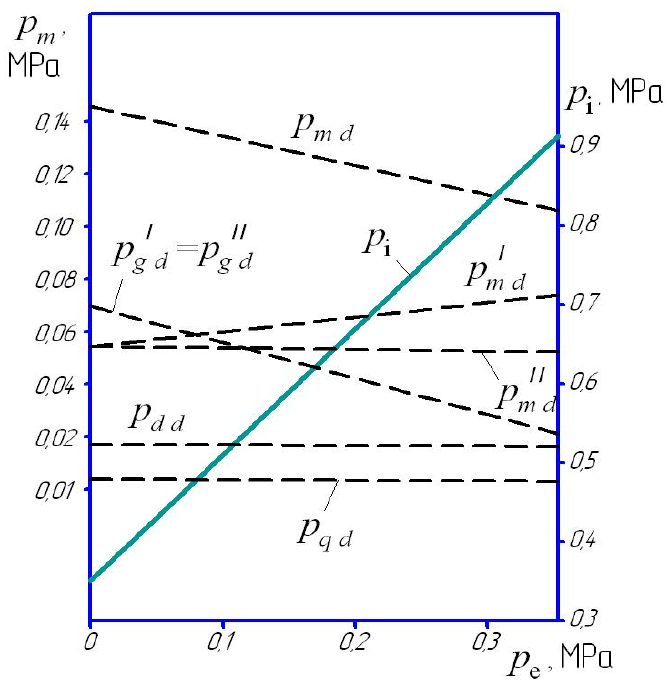
Figure 3. The dependencies of engine parameters on average effective pressure when three cylinders are switched off ( n = 1800 rpm).